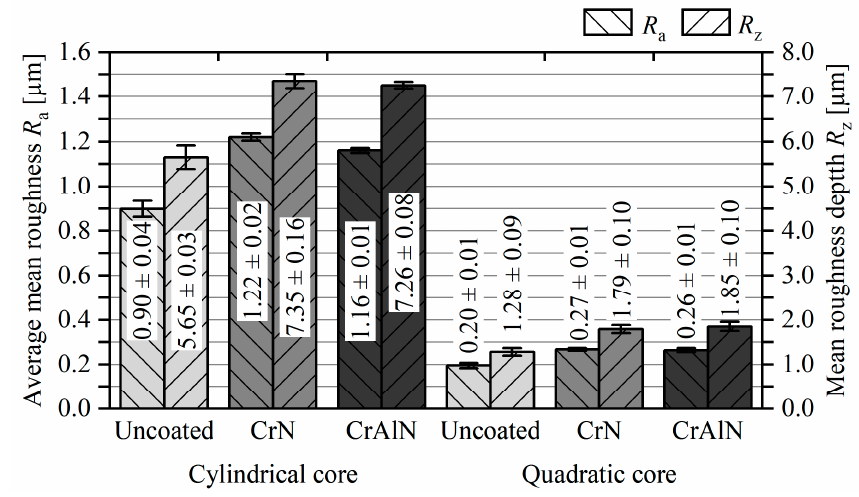
Figure 4. Average mean roughness R a and mean roughness depth R z of uncoated as well as as-deposited CrN and CrAlN coated cores.